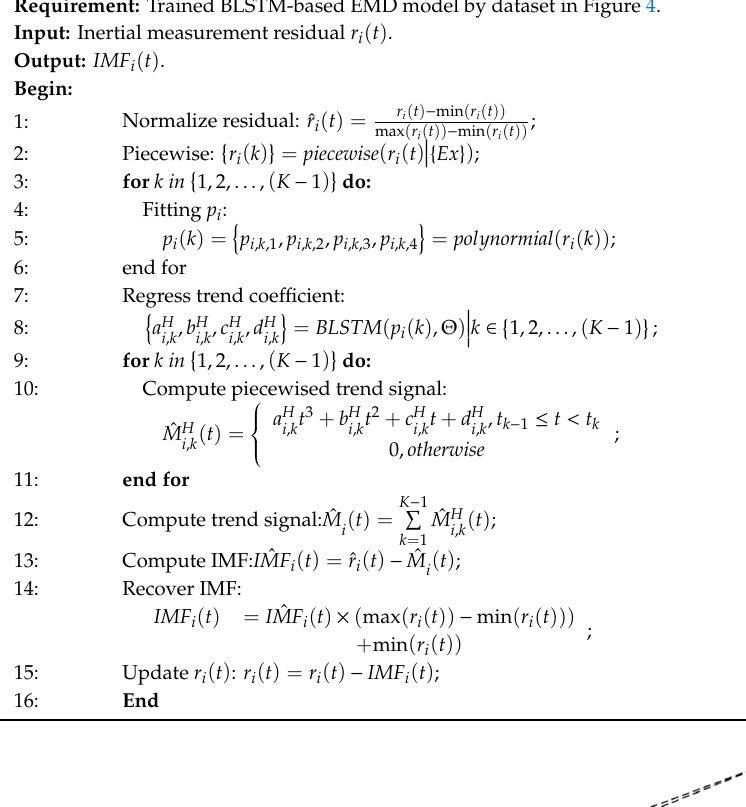
Algorithm 1: BLSTM-based EMD Requirement: Trained BLSTM-based EMD model by dataset in Figure 4.